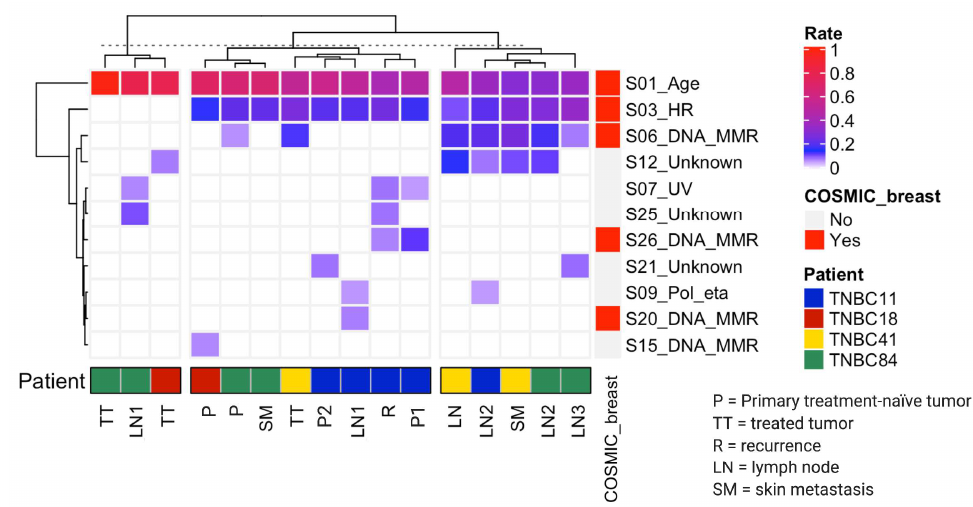
Figure 3. Mutational signature profile in TNBC patients. The samples are ordered according to the hierarchical grouping by mutational signature composition described above. The band of COSMIC breast describes the signatures found in the database of COSMIC Sanger, and the color palette shows the frequency of signatures in each sample. Rate is expressed as the relative frequency of the mutations associated with the corresponding signature. Mutational signatures previously identified in breast cancer samples in the COSMIC database are shown in red boxes. Patients are color-coded as in Figure 2. The tissue origin of the sample is